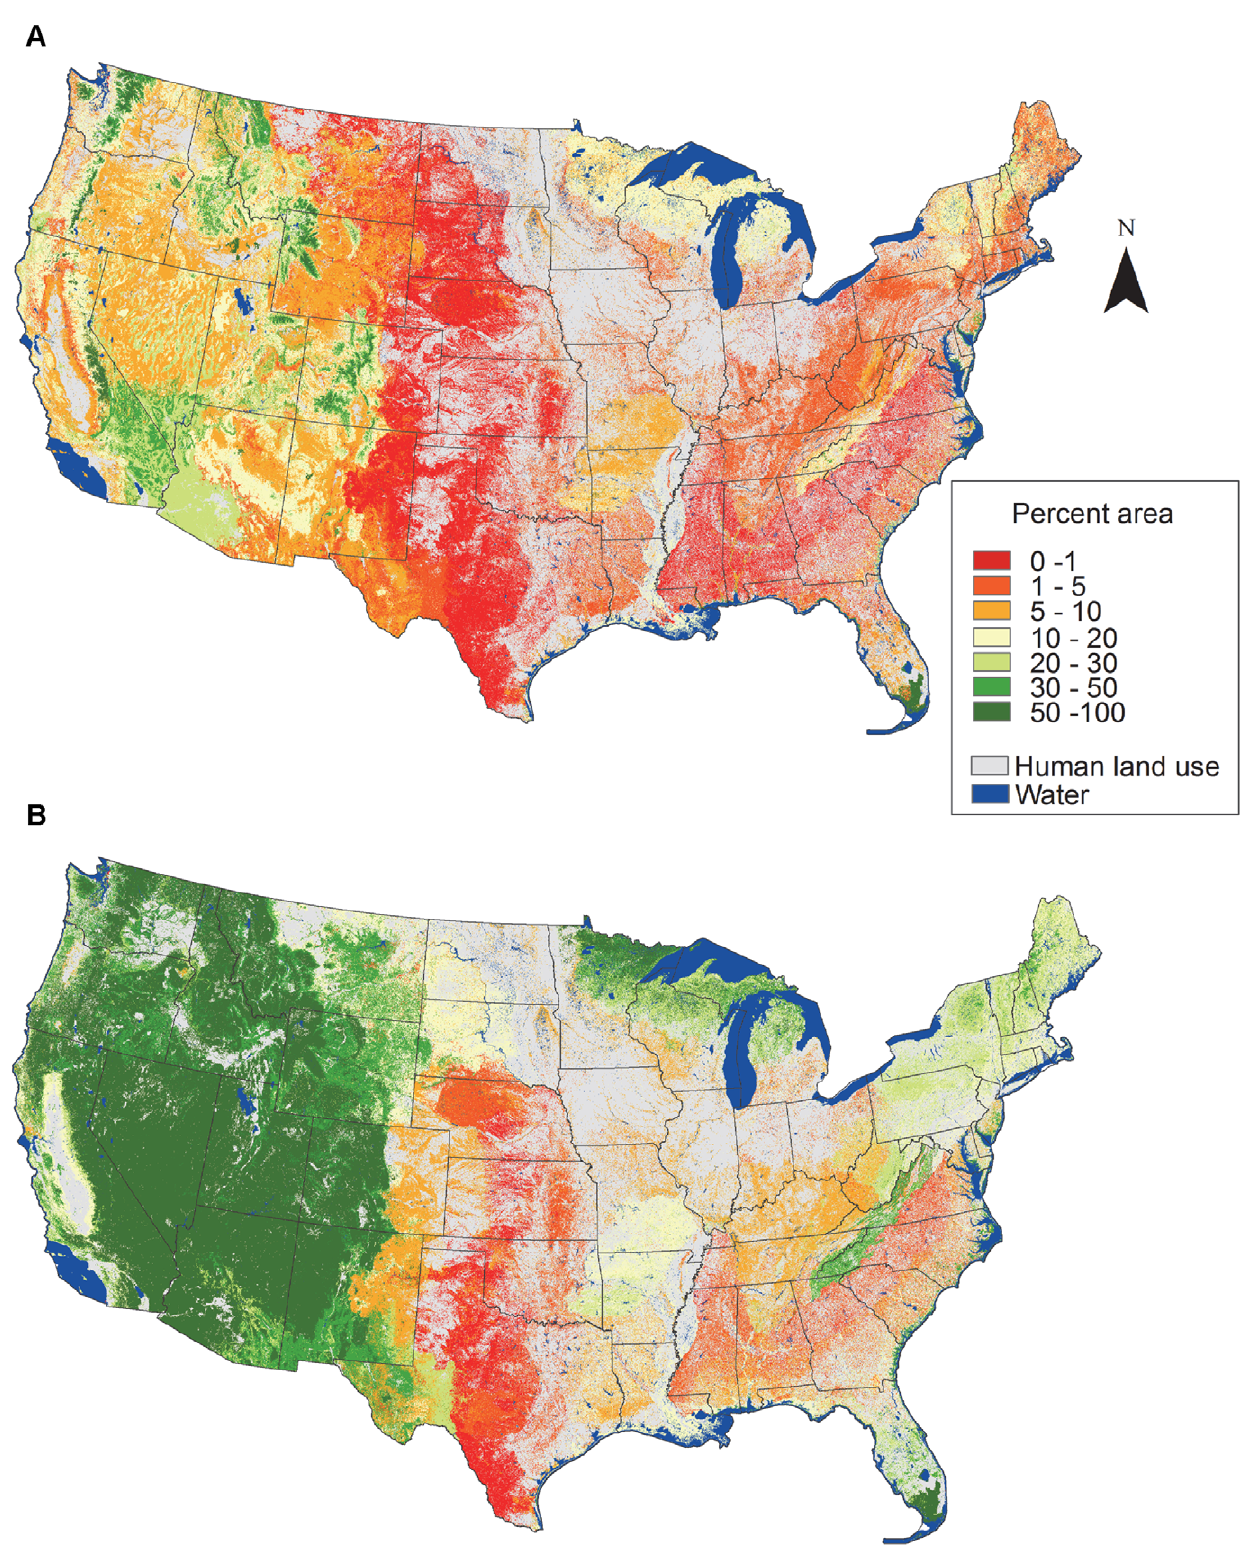
Figure 4. Percent area of ecological systems by protection status. Protection status designations are lands managed to maintain biodiversity (A) and lands managed to maintain biodiversity and multiple-use (B) for the continental US. Percent area is based on the area of each ecological system within each protection status divided by the total area of each ecological system [23,24]. See Table 1 for protection status descriptions. Only non-modified, non-aquatic ecological systems were included (n=518; Table S1).